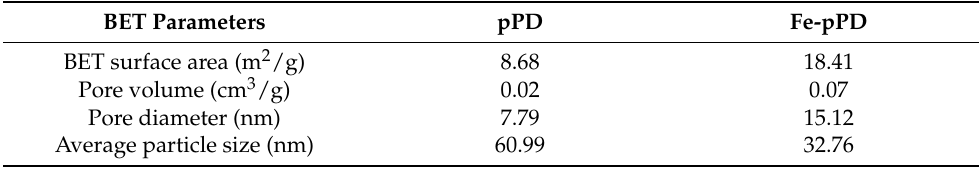
Table 1. BET analysis results of bare pPD and